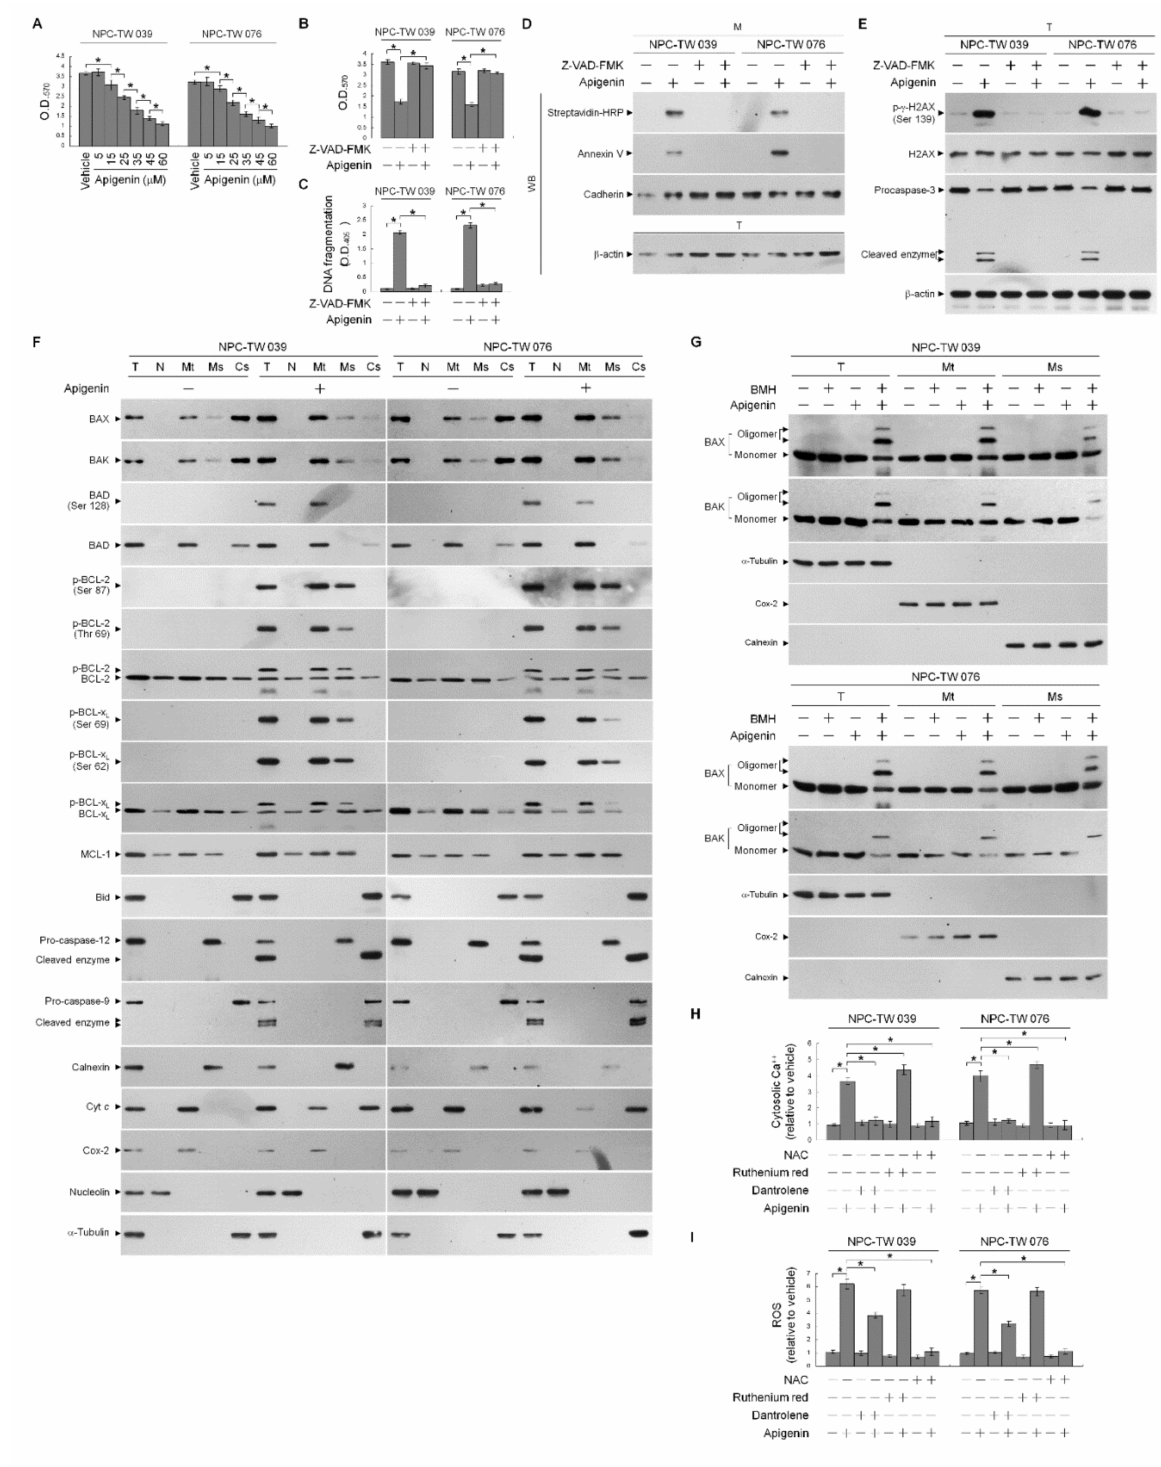
Figure 1. Apigenin-induced B cell lymphoma 2 (BCL-2) (Thr 69 and Ser 87)/BCL-2/B-cell lymphoma-extra large (BCL-x L ) (Ser 62) phosphorylation and Bcl-2-associated x protein (BAX)/Bcl-2 antagonist killer 1 (BAK) endoplasmic reticulum (ER)–mitochondrial oligomerization associated with ER–mitochondria dysfunction and apoptotic death of nasopharyngeal carcinoma (NPC) cells. ( A ) The effect of apigenin on NPC cell growth. Cells were treated with vehicle ( − ) or the indicated concentrations of apigenin for 36 h. Cell growth was determined by the 3-(4,5-dimethylthiazol-2-yl)-2,5-diphenyltetrazolium bromide (MTT) assay. ( B – E ) The effects of apigenin on the induction of NPC cell growth inhibition and apoptosis.